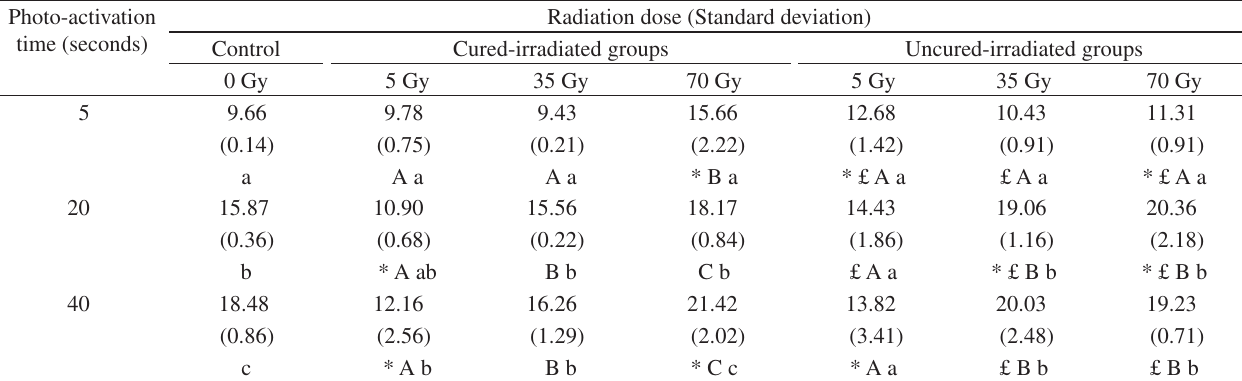
Table 2. Microhardness averages and standard deviations of the Fill Magic Flow ® material. Photo-activation